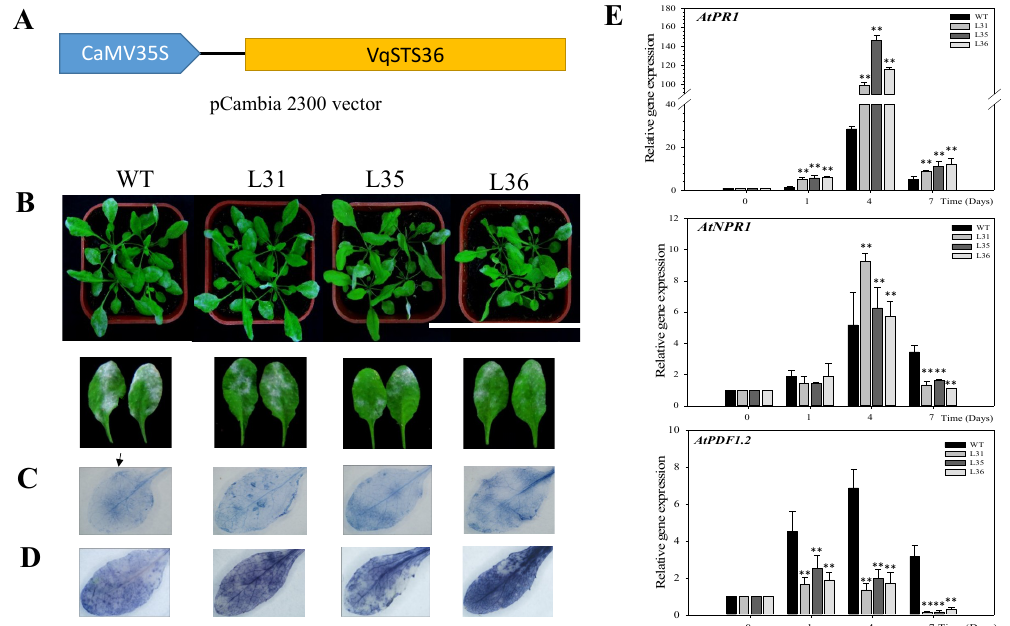
Figure 1. Performance of VqSTS36 transgenic Arabidopsis following inoculation with powdery mildew and expression of defense-related genes. ( A ) Vector map of pCambia 2300:CaMV35S- VqSTS36 . ( B ) Representative images of plants were taken at 7 days post-inoculation (dpi). ( C ) Trypan blue to detect cell death on leaves was used at 4 dpi. ( D ) Nitro blue tetrazolium (NBT) staining to detect superoxide anion accumulation, as noted by arrows. ( E ) Relative expression levels of defense-related genes in leaves collected at 0, 1, 4, and 7 dpi. Data represent mean values ± SD (with values from time point 0 hours post-inoculated (hpi) set to 1) from three independent experiments. Asterisks indicate significant differences between wild-type (WT) and transgenic lines as determined by Student’s t -test. (** p < 0.01).